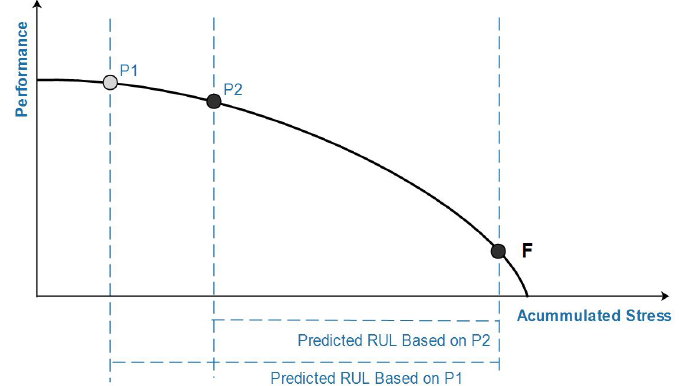
Figure 7. RUL prediction